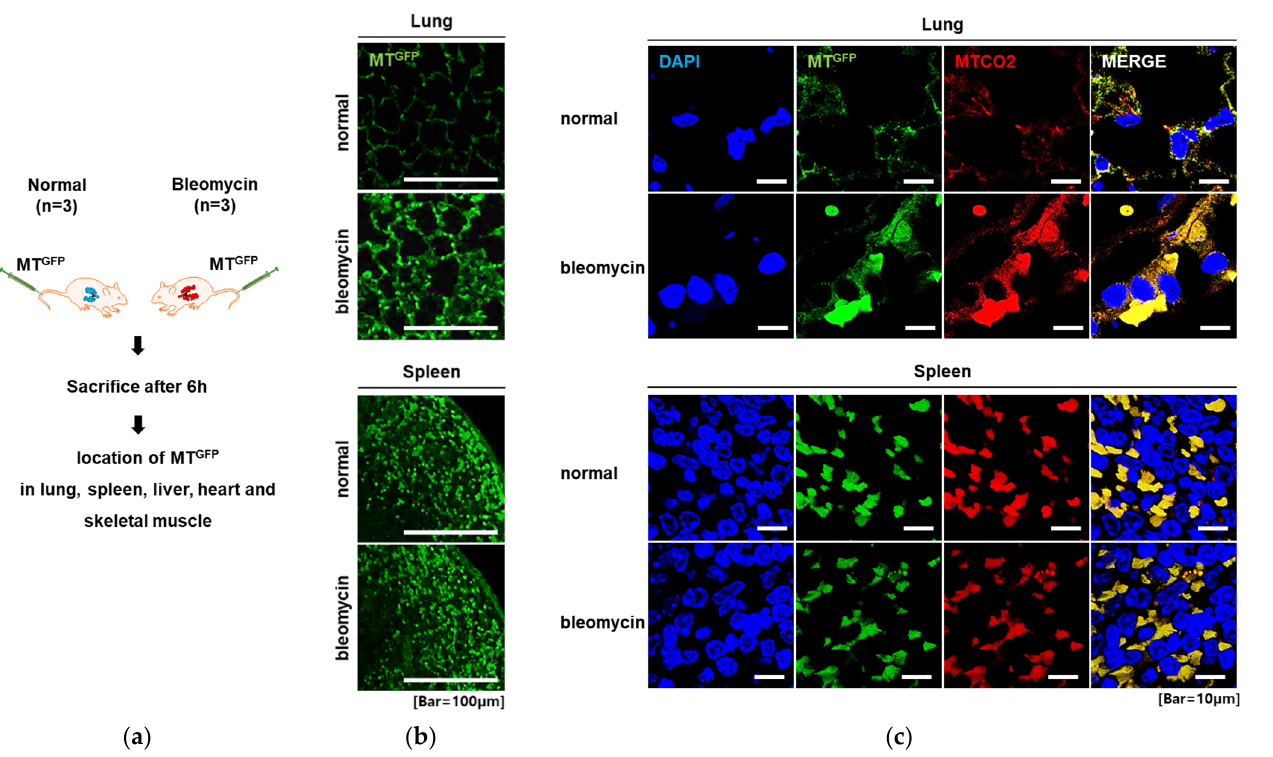
Figure 4. MTGFP trafficking to the lung tissue of BLM-induced IPF mice. ( a ) Schematic illustrating the experimental approach. ( b ) In vivo tracking of MTGFP in the lung and spleen. Normal and BLM-induced IPF mice were administered 10 µ g of MTGFP intravenously. BLM-induced IPF mice showed stronger fluorescent signals in the lung than those of normal mice, whereas similar signals were detected in the spleens of these mice. Scale bar: 100 µ m. ( c ) In the lung and spleen tissues of mice, MTGFP (green) were colocalized with MT-CO2 (red), which was detected using a human-specific anti-MT-CO2 antibody. Cell nuclei were stained with DAPI (blue). Scale bar: 10 µ